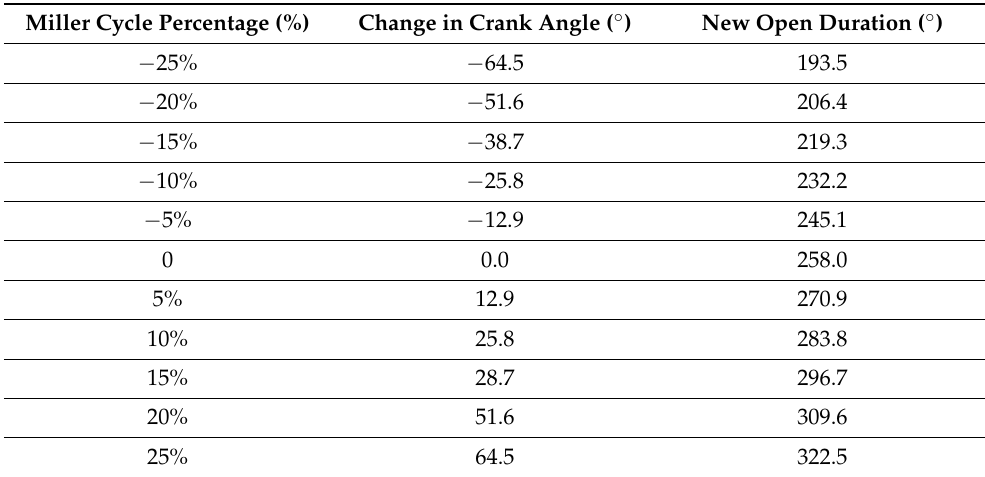
Table 3. The test conditions of Miller